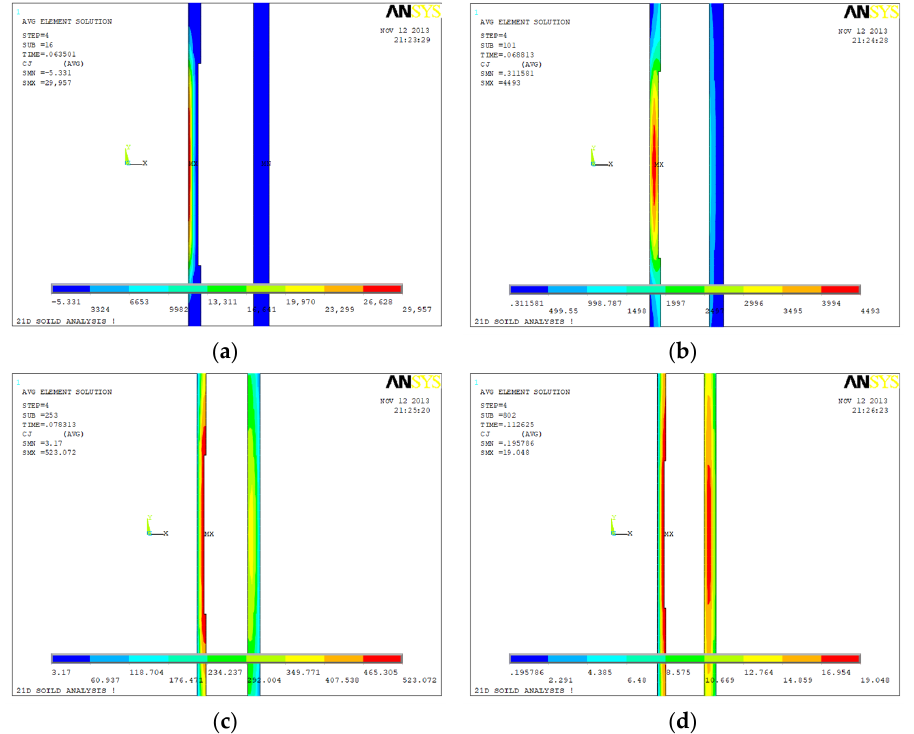
Figure 7. Eddy current distribution during power-off time in the inspection for undamaged casing plus corroded tubing: ( a ) 0.0635 s (time slices Nos. 16); ( b ) 0.0688 s (time slices Nos. 22); ( c ) 0.0783 s (time slices Nos. 26); ( d ) 0.112 s (time slices Nos. 31)